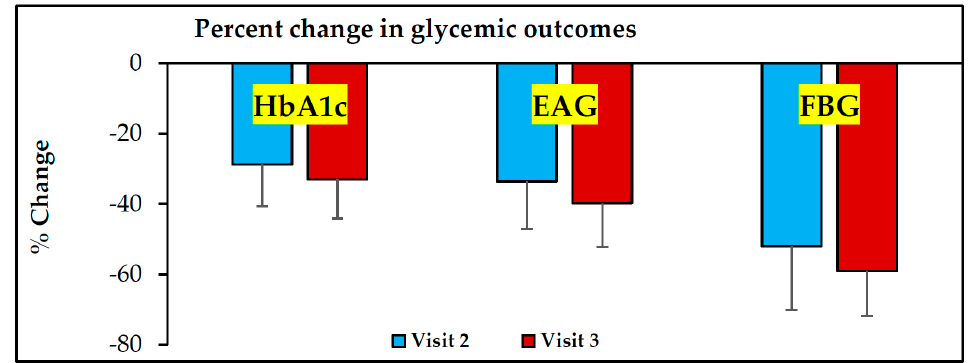
Figure 4. Percent decline in glycemic indices after receiving ABCDE. Visit–1 = first visit where ABCDE was provided; Visit-2 and Visit-3 = visits 3- and 6 months after Visit–1. HbA1c = glycosylated hemoglobin, EAG = estimated average glucose, FBG = fasting blood